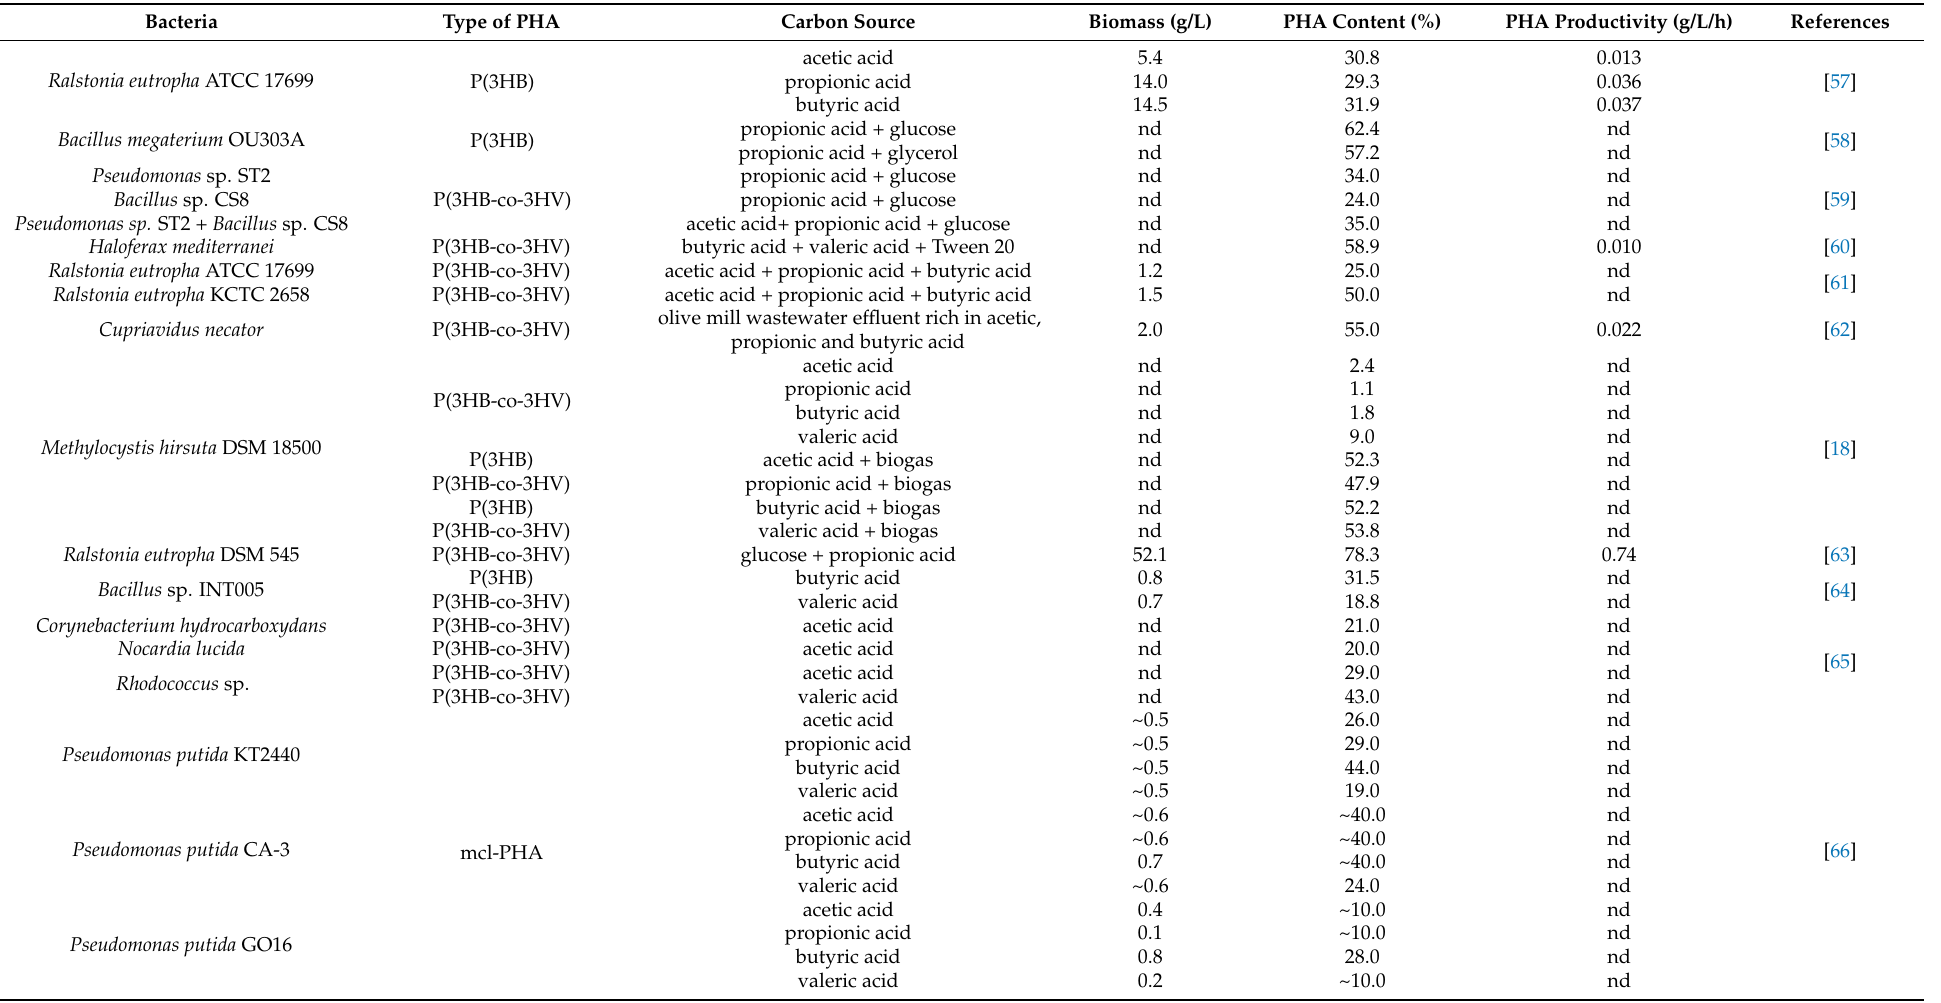
Table 3. Production of PHAs by pure bacterial cultures using volatile fatty